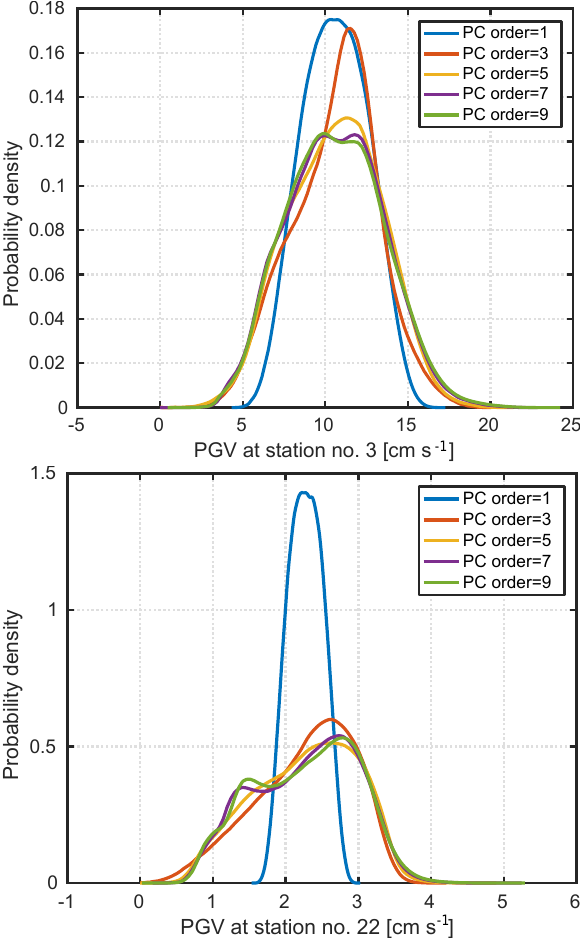
Figure 4. PC-predicted PGV distributions at two selected stations (as indicated in Fig. 2). Distribution curves are obtained using ker- nel density estimation (Sheather and Jones, 1991) from PC realiza- tions on a 1million member LHS set P 1E6 LHS